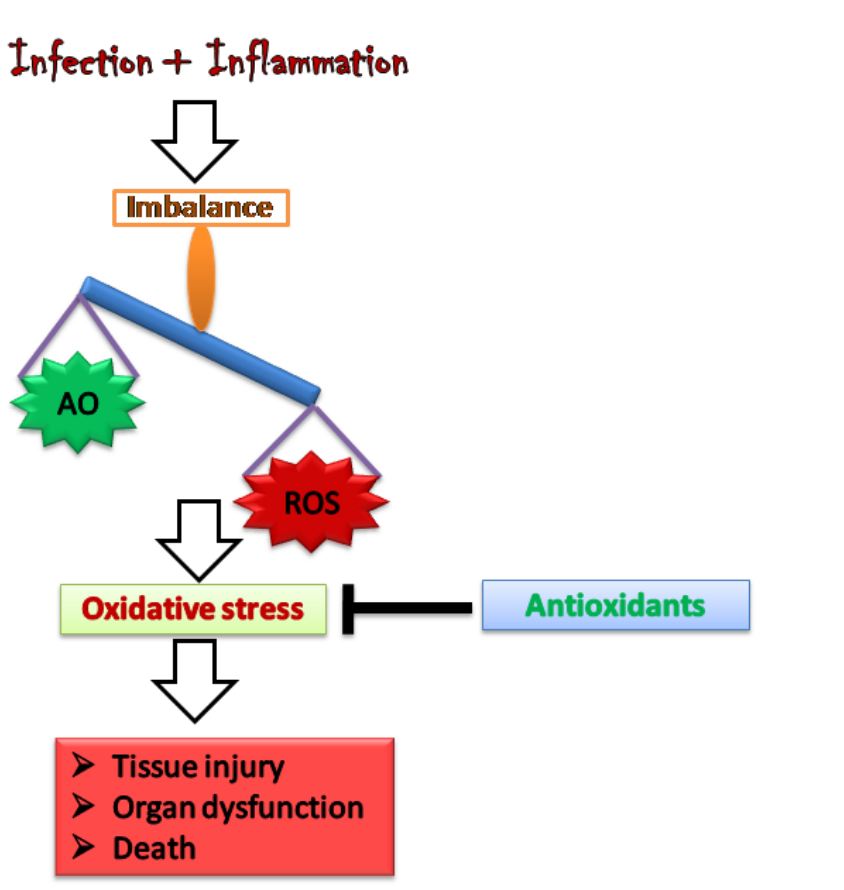
Figure 3. ROS: to maintain their functions and to avoid the negative effects of excessive ROS generation, immune cells require optimal amounts of antioxidant defenses. This figure shows antioxidants’ general protective mechanism in sepsis. Table 3. Antioxidants investigated in sepsis and used in animal and clinical trials.